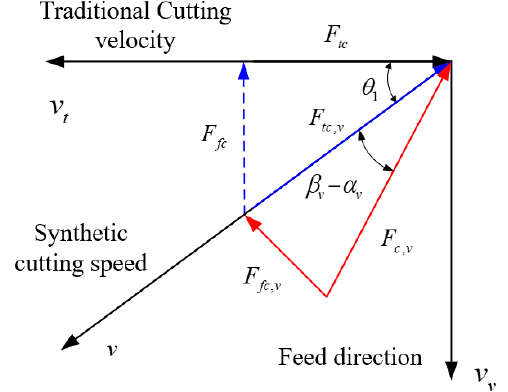
Figure 5. The relationship of cutting force in two coordinate systems.